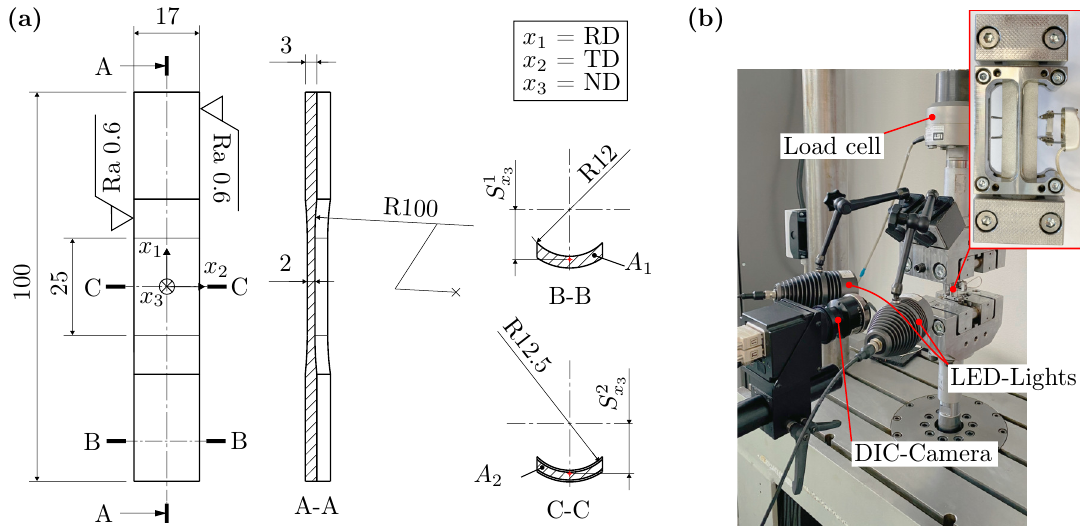
Figure 2. Hot-bent uniaxial specimen: ( a ) Geometry details of the hot-bent uniaxial specimen and ( b ) the test setup for quasi-static and cyclic